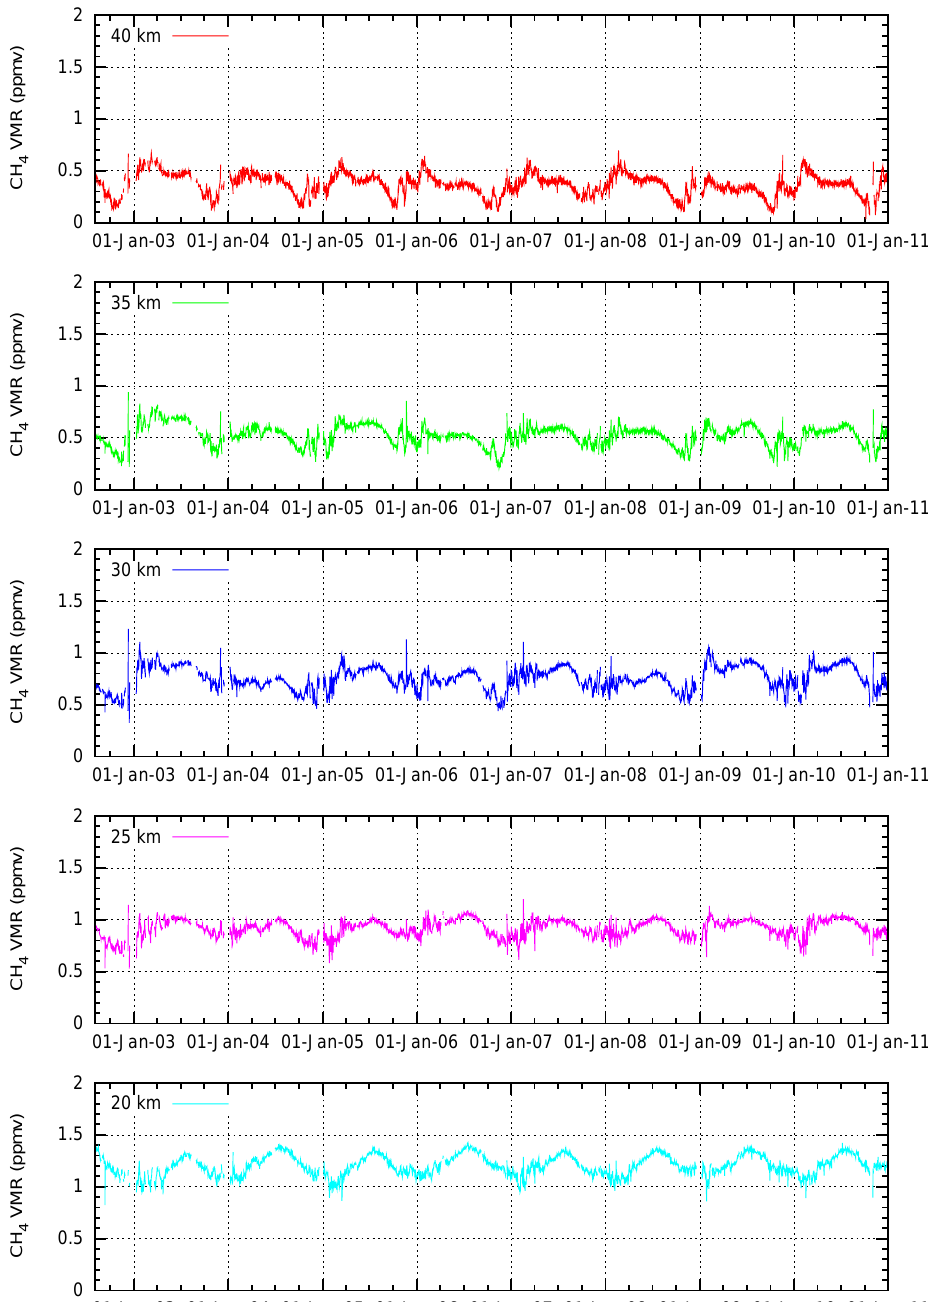
Fig. 5. Time series of SCIAMACHY CH 4 VMRs (August 2002 to December 2010) at different altitudes based on daily average data.